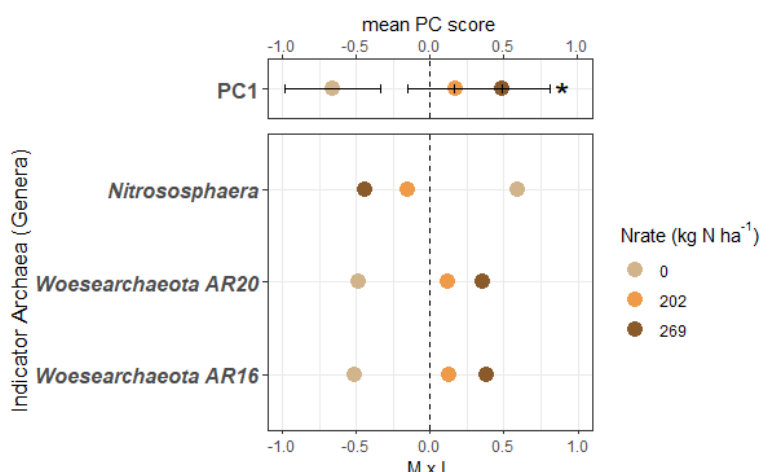
Figure 5. The top panel shows the estimated mean principal component (PC) scores of the archaeal PC1 for each level of N rate treatment with their standard errors of the mean as whiskers. The asterisks indicate the probability value of the treatment effect from analysis of variance (*: p < 0.1). The bottom panel shows the contribution of each archaeal bioindicator to PC1 multiplied by the mean PC scores of each level of N treatment (M × L). The treatment levels are: 0 kg N ha − 1 (tan), 202 kg N ha − 1 (orange), and 269 kg N ha − 1